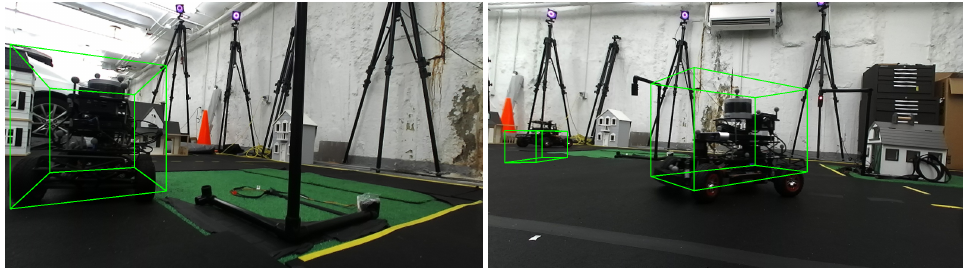
Figure 10. Ground truth bounding boxes (green) are automatically generated from the MiniCity’s external motion capture system. Ground truth bounding boxes can used for detector training, algorithm evaluation, and isolating downstream